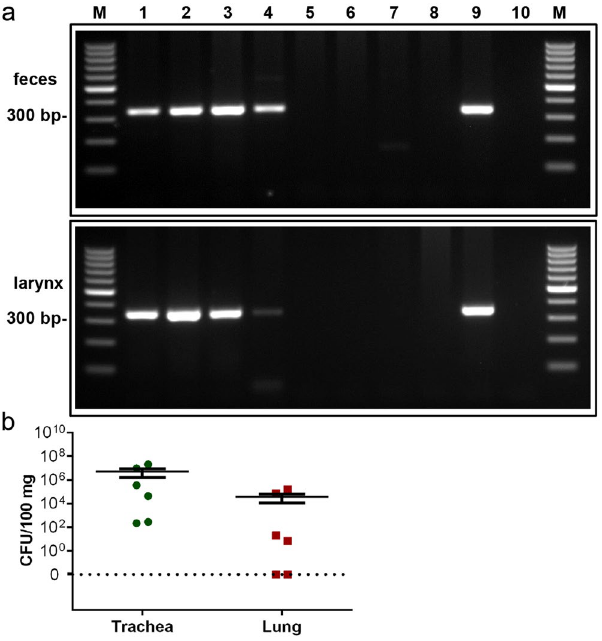
Figure 2. Detection of genomic Bordetella DNA by PCR. ( a ) A PCR product of 318 bp was amplified with B. pseudohinzii -specific primers from DNA of faeces (upper panel) and larynx (lower panel) from infected (lanes 1–4) and non-infected (lanes 5–8) mice, as classified by MALDI-TOF MS. DNA isolated from cultured B. pseudohinzii (strain 3227) served as a positive control (lane 9). Control runs without template were negative (lane 10). M: 100 bp molecular weight marker. ( b ) Trachea and lung taken were taken from 6 animals which were positive for B. pseudohinzii by PCR of faecal pellets, homogenized, and plated on selective agar plates. Number of colony forming units (CFU) is given per 100 mg of tissue. Individual data points shown; horizontal bar and whiskers indicate mean and standard error of the mean. Weight of tissue samples and CFU/organ are provided in Supplementary Table